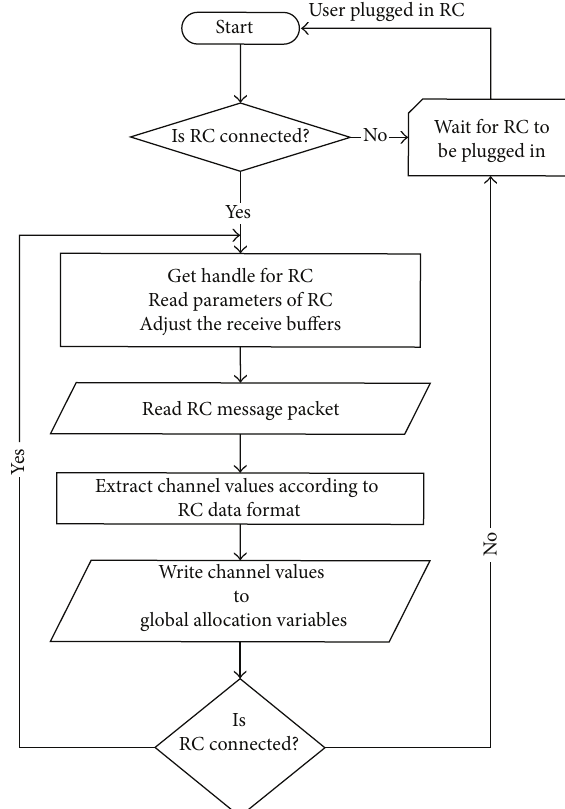
Figure 7: Remote control guidance device interface flowchart.